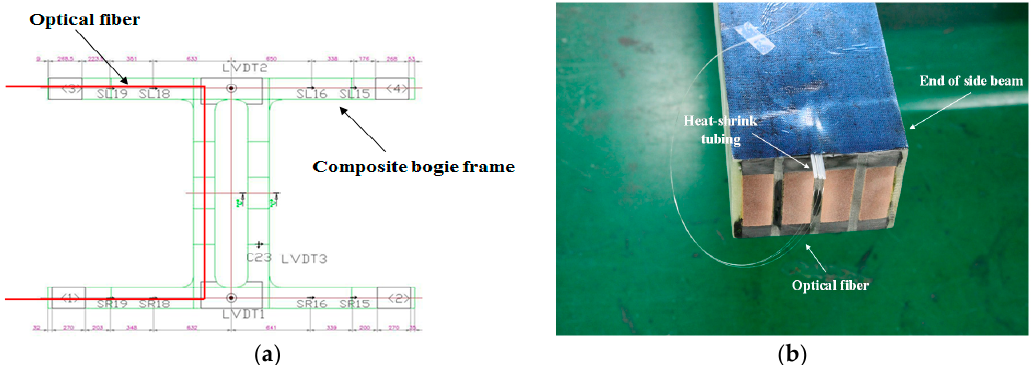
Figure 4. Embedding process of optical fiber: ( a ) location of the optical fiber embedded in the composite bogie frame; ( b ) optical fiber embedding process.